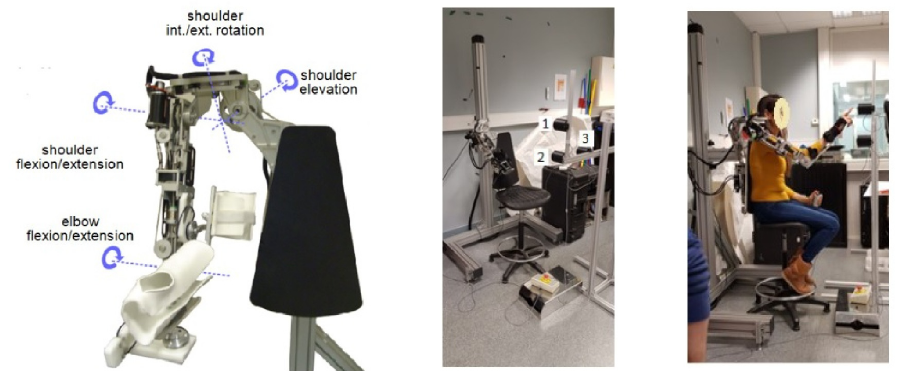
Fig 4. The experimental setup. The ABLE exoskeleton imposes a viscous field on the subjects, forcing them to change their kinematic behavior.